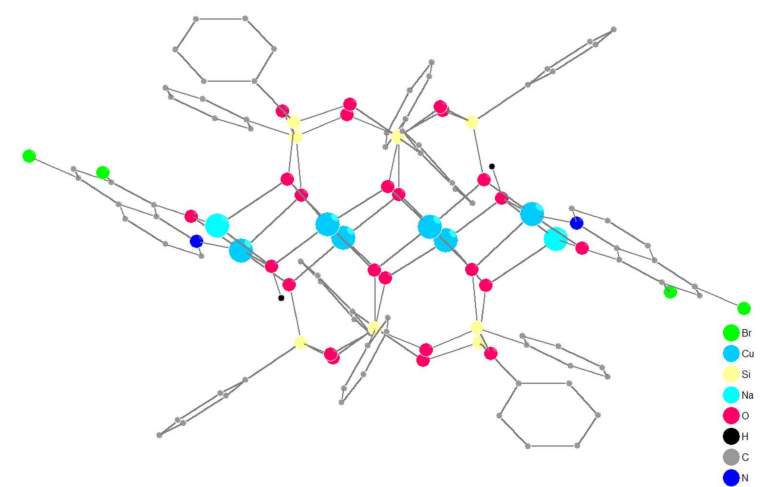
Figure 3. Top . The molecular structure of 2 . Middle . The molecular structure of 3 . Bottom . The molecular structure of 4